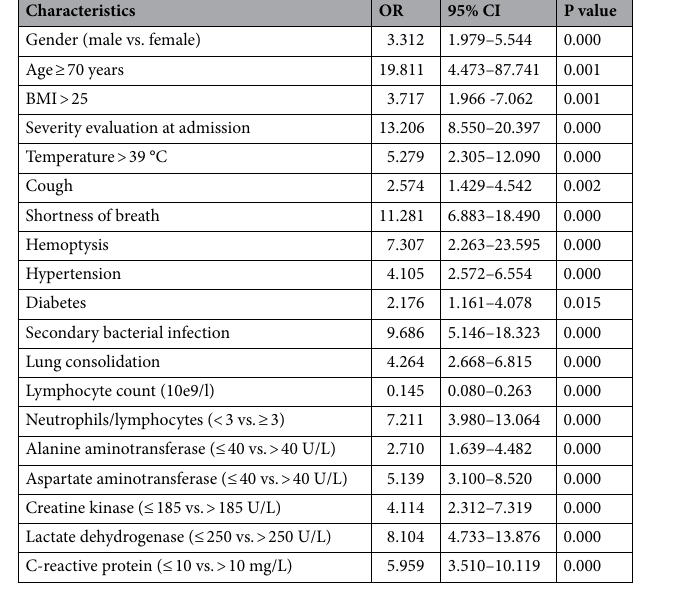
Table 4. Risk factor analysis for COVID -19.